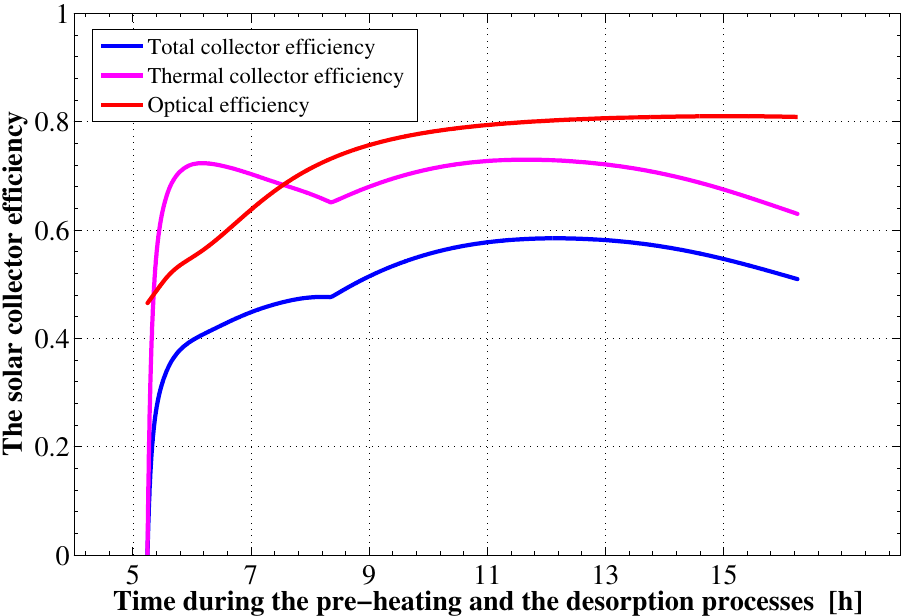
Figure 4. Time variation of the solar collector thermal, optical, and total efficiencies during the pre-heating and desorption